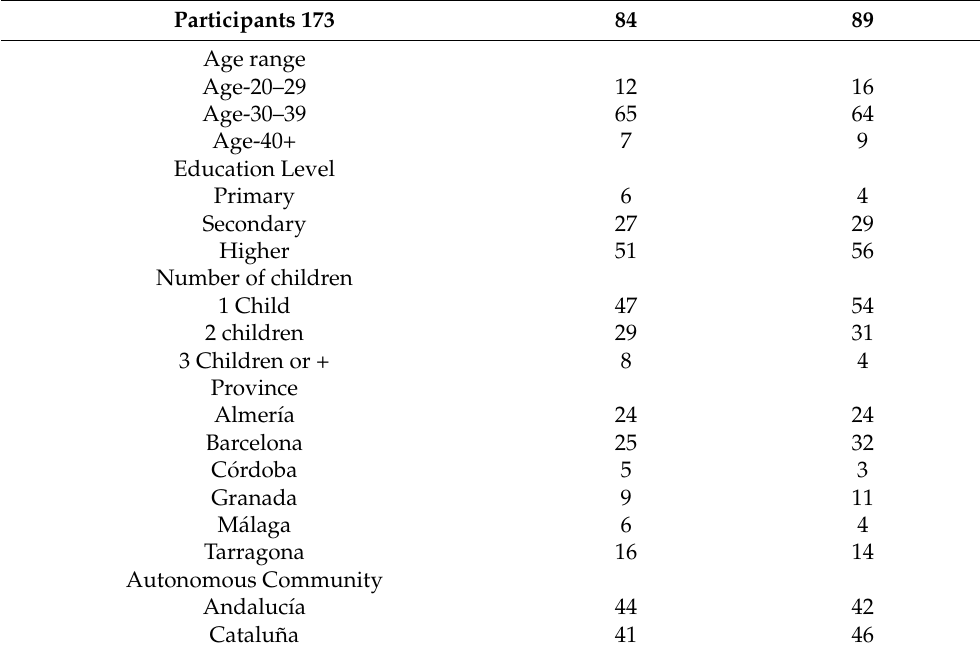
Table 1. Characteristics of the pregnant and breastfeeding women participants.